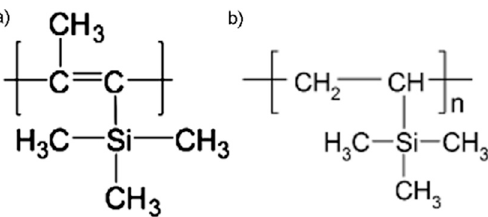
Figure 1. Structural formulas of the polymers PTMSP ( a ) and PVTMS ( b ) used in this work.